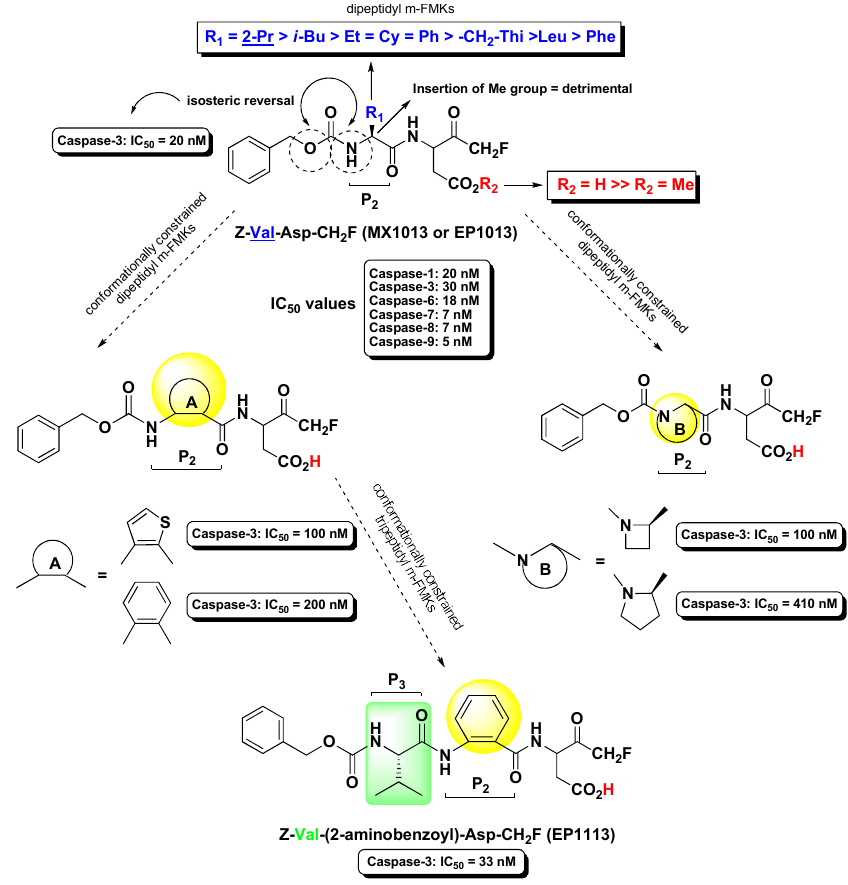
Figure 3. Chemical structures, progressive structure–activity relationship (SAR) analysis, and some biological results of the most relevant m-PFMKs developed by Wang Y. et al.